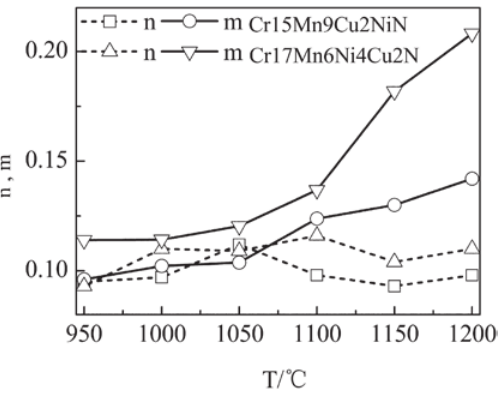
Fig. 9: m value and geometric instability